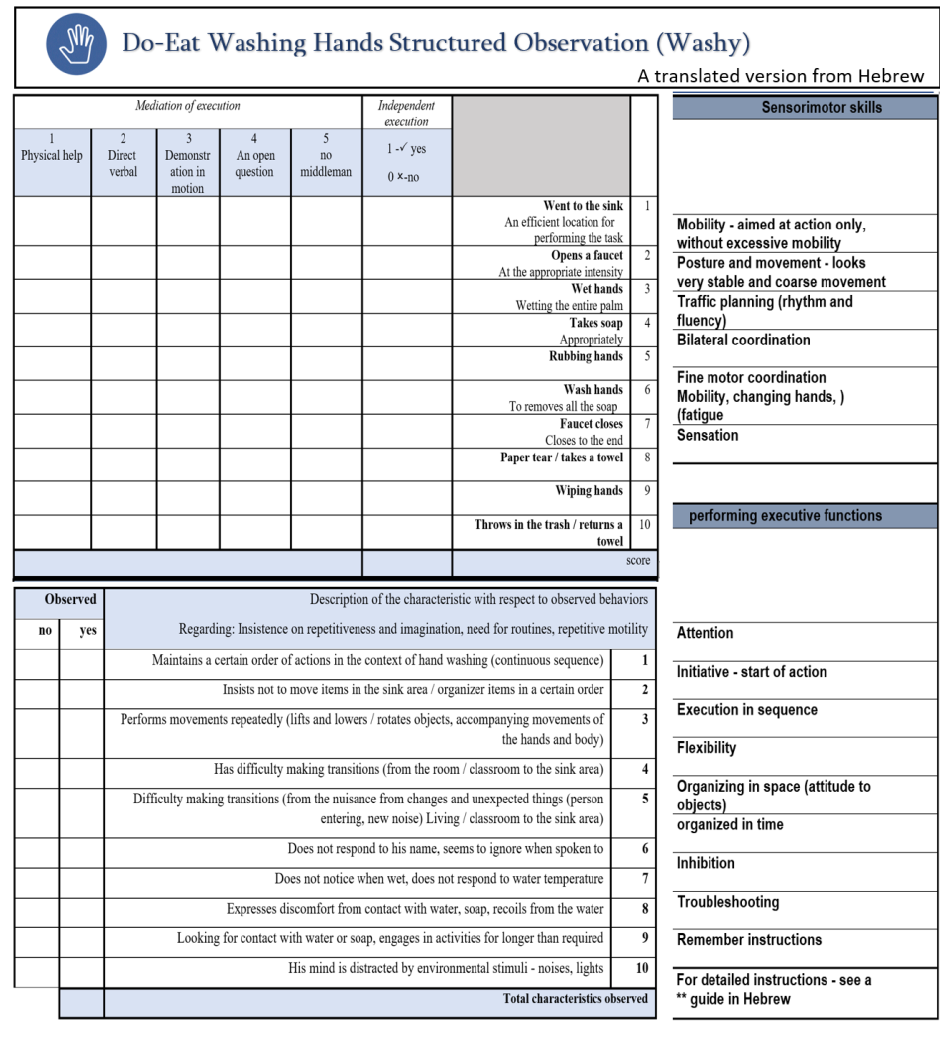
Figure A1. The Do-Eat Washing Hands Structured Observation (Washy)